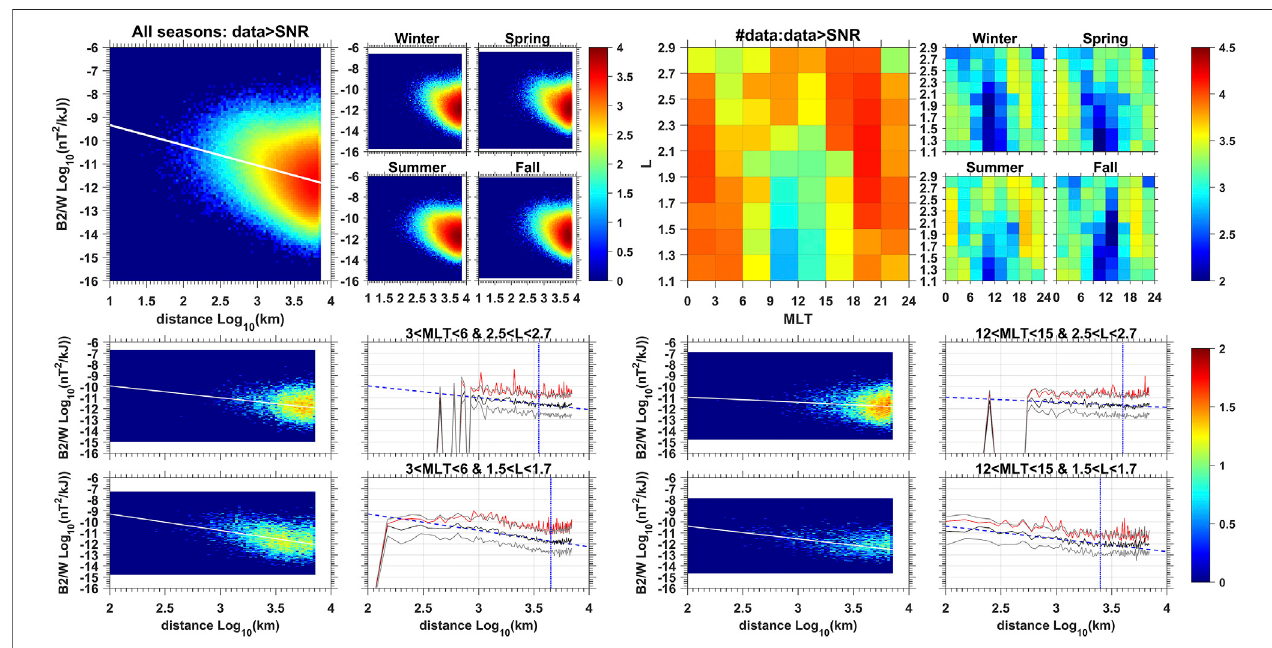
FIGURE 2 | Same as Figure 1 for the LGW magnetic power (in nT 2